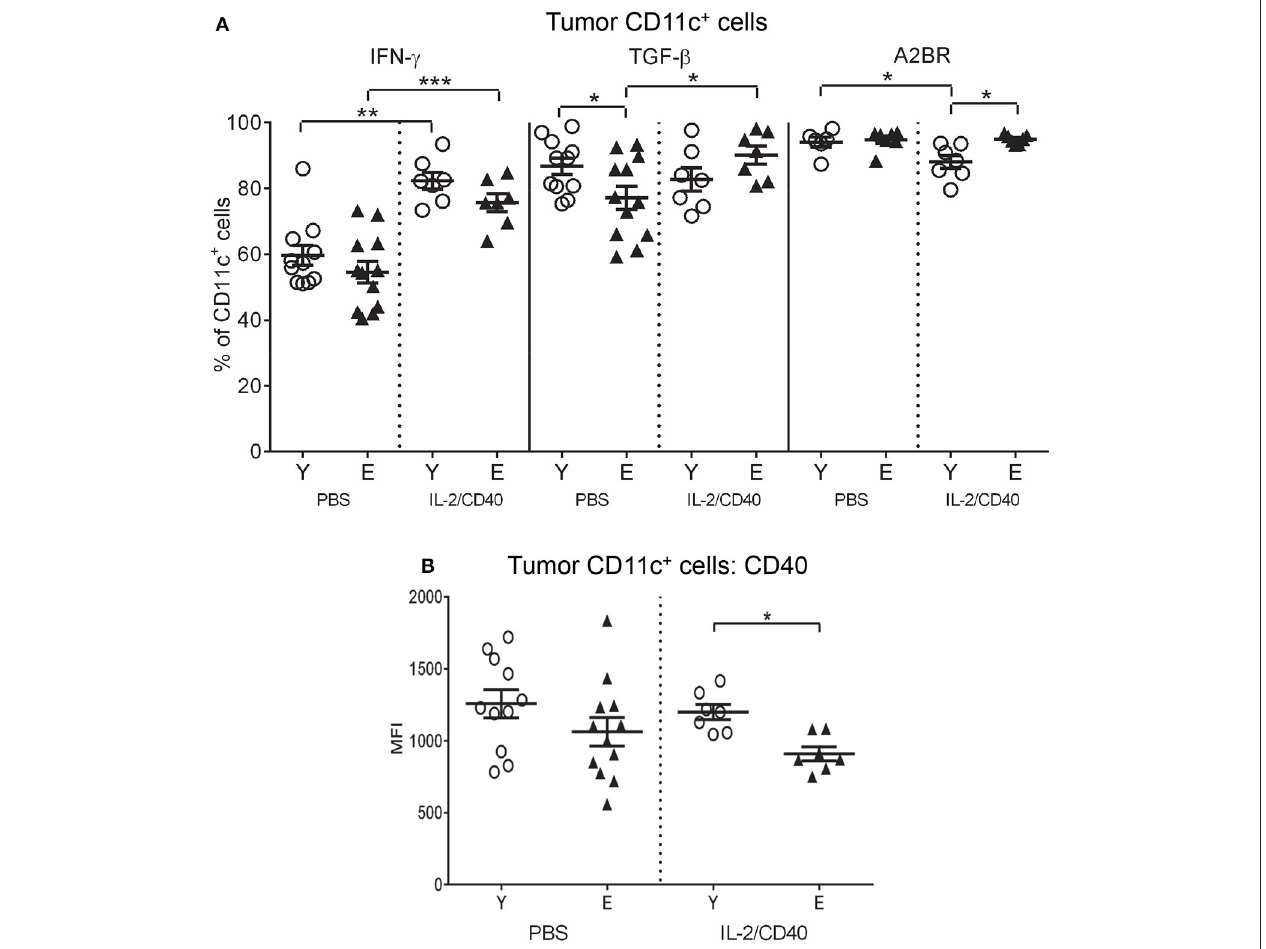
FIGURE 9 | Increased IFN- γ , TGF- β , and A2BR, and reduced CD40 on CD11c + cells from elderly IL-2/CD40-treated tumors. After two doses of IL-2/CD40 or PBS diluent, percentages of CD11c + cells positive for IFN- γ , TGF- β and A2BR (A) and expression levels of CD40 (shown as geometric mean fluorescence intensity; MFI) on CD11c + cells (B) were measured from the young and elderly tumor-bearing mice described in Figures 5B,C using flow cytometry. Data are shown as mean ± SEM, n = 7 young and n = 7 elderly IL-2/CD40-treated mice, n = 6–11 young and n = 7–12 elderly PBS control mice, * p < 0.05, ** p < 0.005, *** p < 0.0005 comparing (i) young to elderly mice, or (ii) IL-2/CD40-treated mice to age-matched PBS control